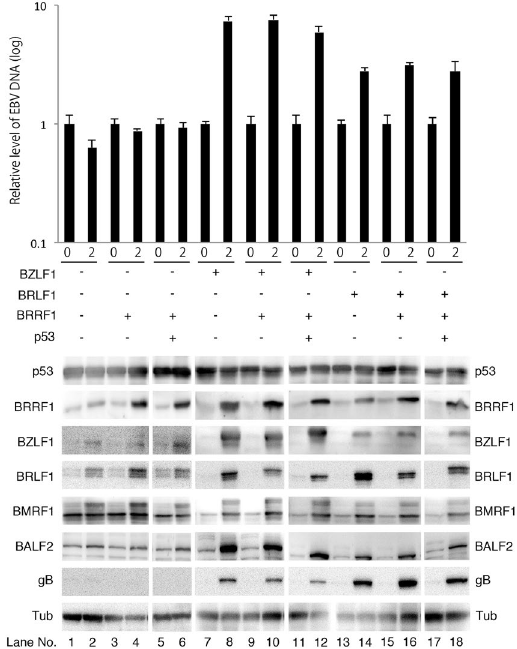
Figure 8. Lytic protein expression and EBV DNA synthesis in HEK293 cells harboring EBV after forced expression of BRRF1 and p53 with/without BRLF1 or BZLF1. HEK293 cells harboring the wild-type EBV BAC were transfected with the indicated expression vector. Cells were collected on days 0 and 2 (or day 3 for the BRLF1 experiment) and subjected to immunoblotting and qPCR. The original blots are presented in Supplementary Figures 22–24. EBV DNA levels were analysed by qPCR. Each bar represents the mean and standard deviation of three independent